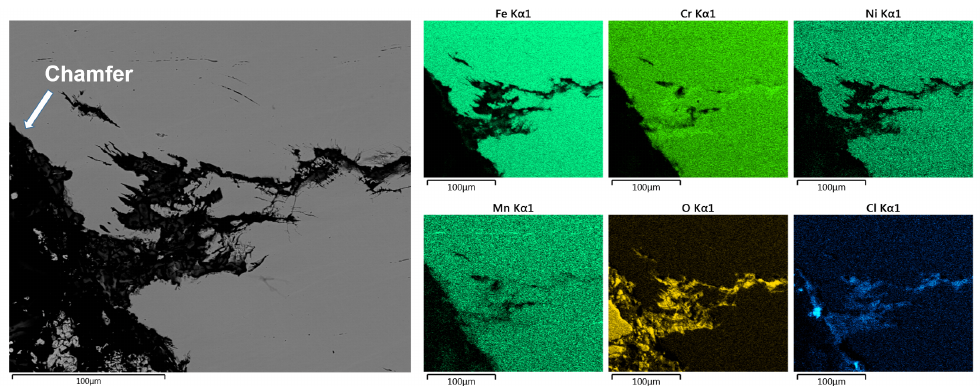
Figure 9. Elemental mapping of stress–corrosion-tested FT1. The analyzed cross section is from a cracked region near the chamfer.